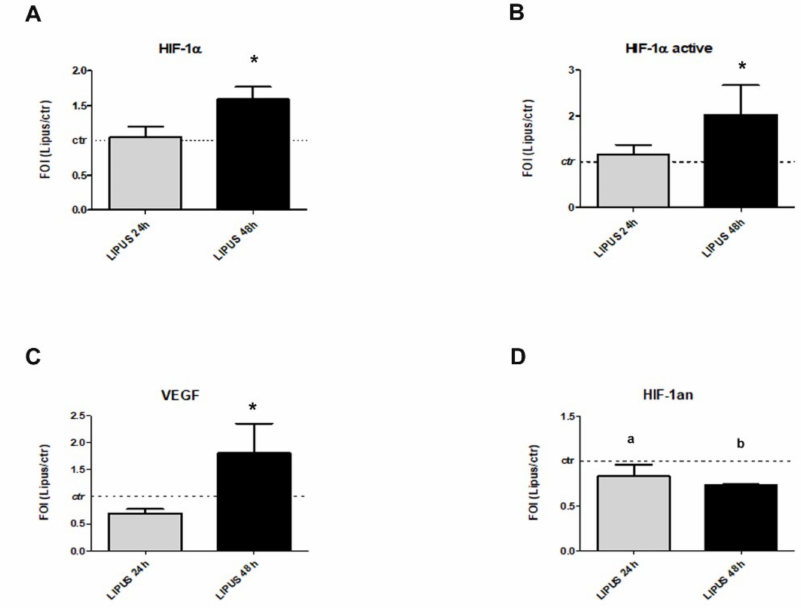
Figure 2. Effects of LIPUS stimulation on hypoxia inducible factor-1 (HIF-1 α ) expression were evaluated by gene expression of HIF-1 α ( A ), VEGF ( C ), hypoxia-inducible factor 1-alpha inhibitor (HIF1AN) ( D ) and proteins analysis of HIF-1 α active ( B ). Quantitative RT-PCR data are expressed as fold of change (FOI) in gene expression (2 − ∆∆ C t ) and occurred in LIPUS compared to untreated groups. ELISA data are expressed as FOI between hMSCs and were stimulated with LIPUS for 24 and 48 h respect to untreated group. Student’s t test: *, p < 0.05 between experimental time; a: p < 0.05; b: p < 0.0005 between LIPUS and untreated groups at each experimental